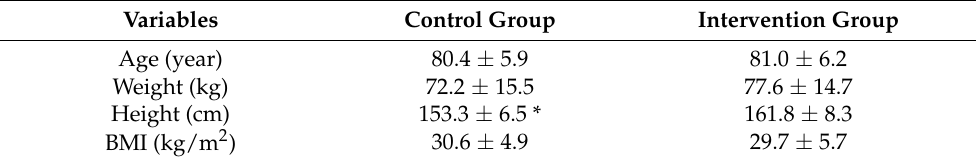
Table 1. Descriptive characteristics of participants assigned to control or intervention groups. Variables Control Group Intervention Group